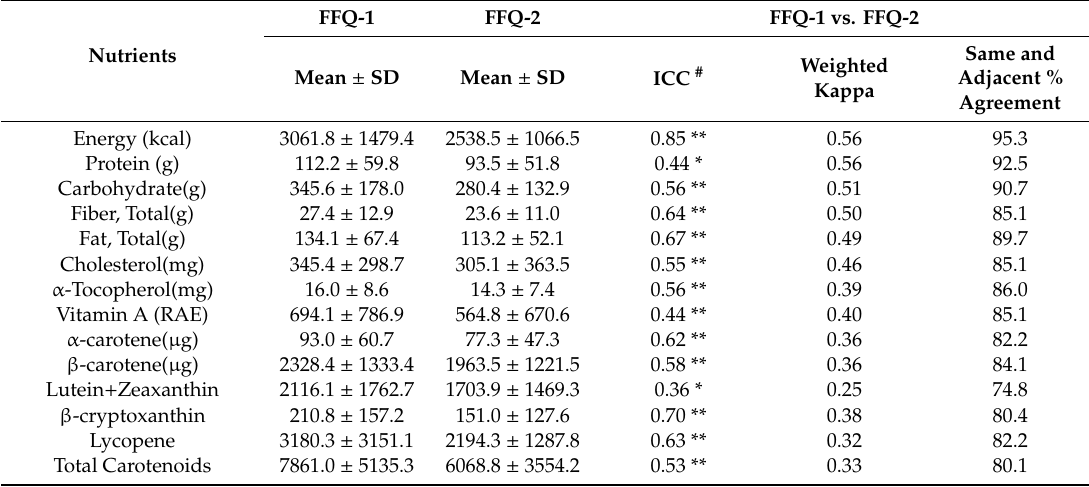
Table 5. FFQ reproducibility: Intraclass correlation coe ffi cients, weighted kappa and same and adjacent % agreement for comparison of FFQ-1 and FFQ-2 ( n =